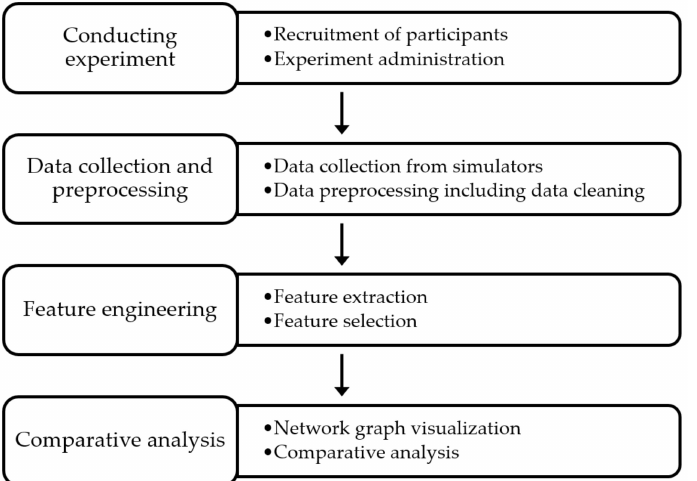
Figure 1. Workflow of the proposed